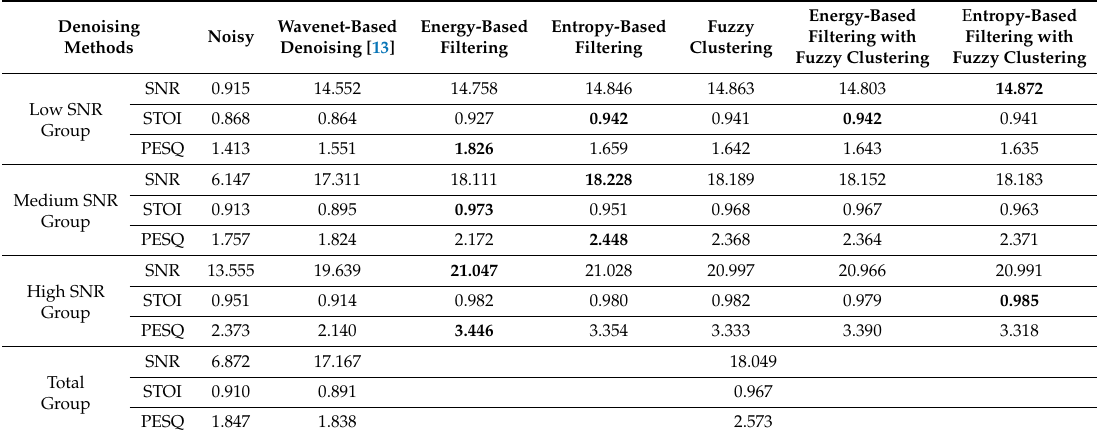
Table 6. The comparison of denoising performance for the final result of each method. Wavenet-Based Denoising Noisy Denoising [13] Methods